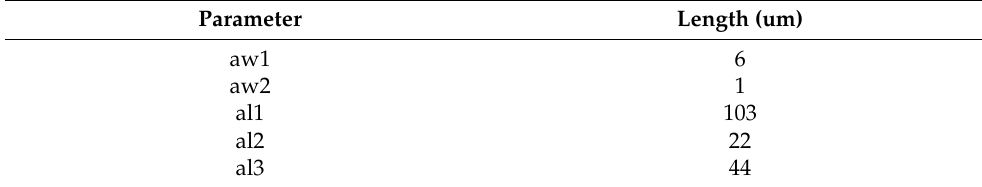
Figure 2. Structure of a dual-band THz antenna. 3D radiation pattern of the antenna at 1 and 2.5 THz. Table 2. Optimal geometric parameters of the dual-band THz